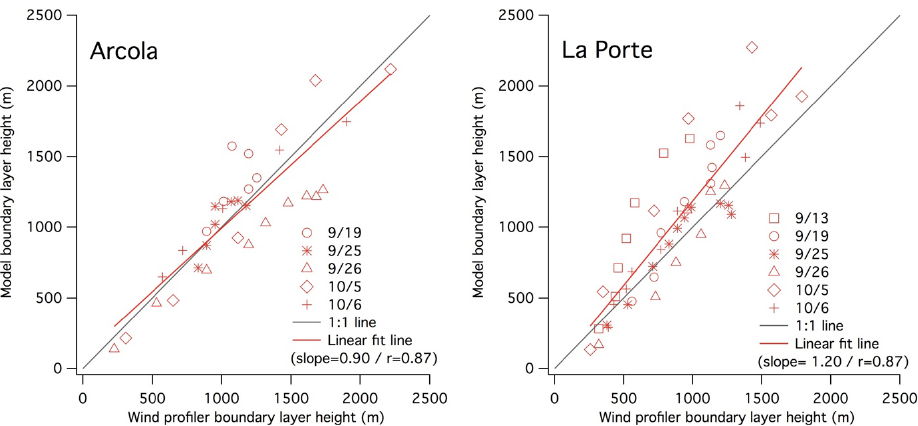
Figure 3. Comparisons of model atmospheric boundary layer heights with radar wind profiler data at Arcola (29.51 ◦ N, 95.48 ◦ W) and La Porte (29.67 ◦ N, 95.06 ◦ W) sites in the Houston-Galveston region. Symbols denote selected dates. Table 4. Geographic information of Texas source boxes used to average satellite and aircraft observations and WRF-Chem model simulations. The dominant source of NO x emissions in each box is indicated by either C = city or P = power